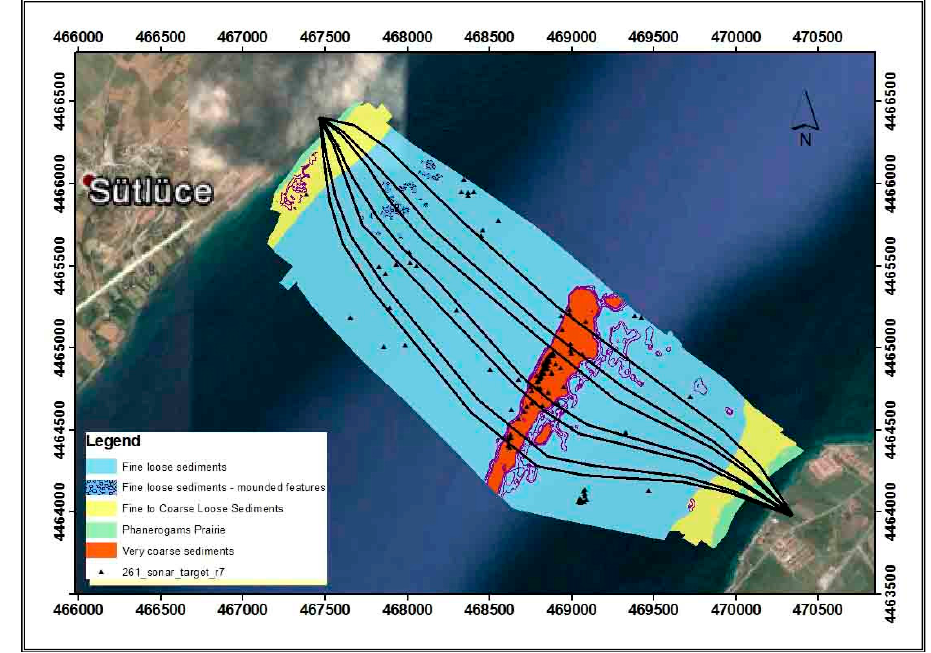
Figure 10 . Seabed categories encountered by the cables of Lâpseki–Sütlüce I. Figure 10. Seabed categories encountered by the cables of L â pseki–Sütlüce I. Table 3. Seabed categories encountered in the cable route. Table 3. Seabed categories encountered in the cable